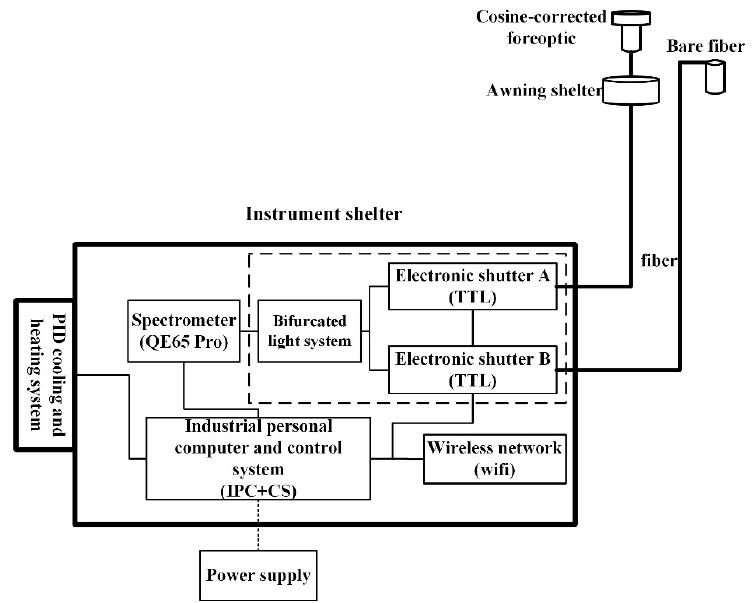
Figure 1. Schematic diagram of the configuration of the solar-induced chlorophyll fluorescence (SIF) measurement (SIFSpec) system. TTL and IPC indicate the electronic shutter and the industrial personal computer,